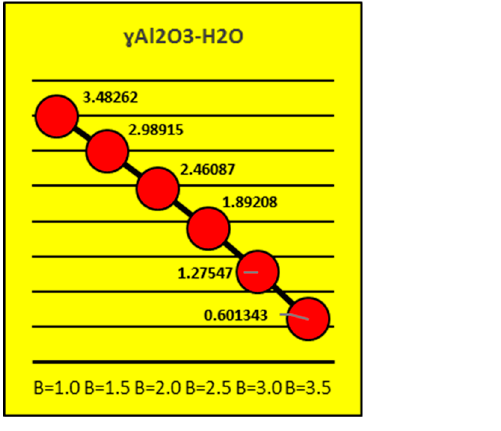
. Figure 14. E ff ects of φ on e ff ective thermal conductivity. Molecules 2020 , 25 , x FOR PEER REVIEW Figure 14. Effects of 𝜙 on effective thermal conductivity